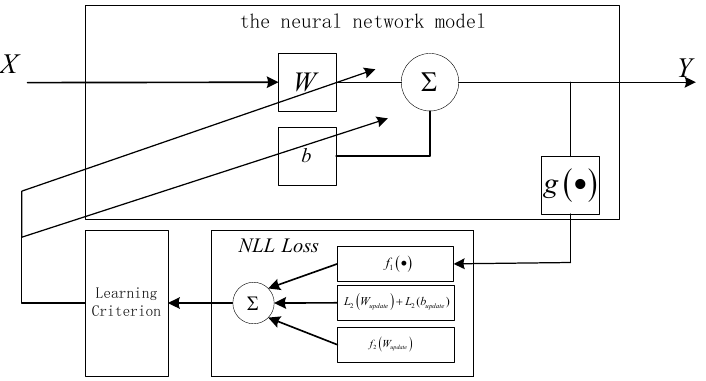
Figure 2. Structure diagram of the blind source separation (BSS) method based on the maximum likelihood estimation (MLE) criterion and a self-organizing